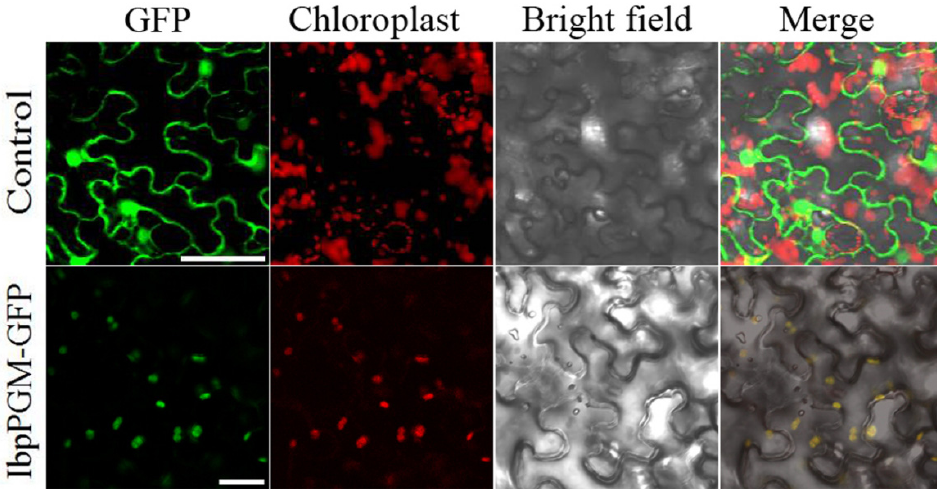
Figure 5. Subcellular localization of the IbpPGM protein in the epidermal cells of N. benthamiana leaves. Bar = 50 μ m.